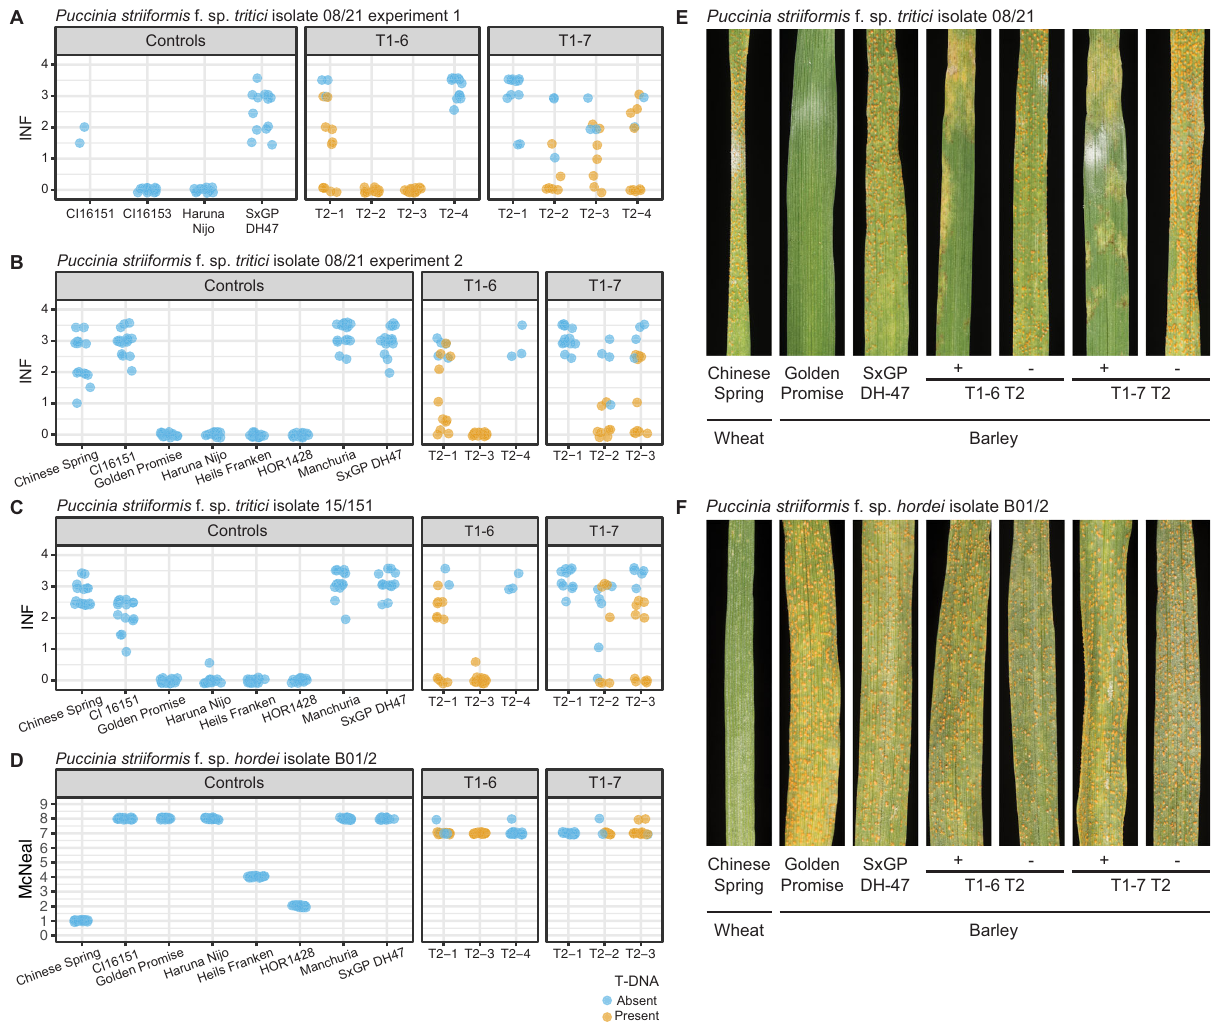
Fig. 6 Mla8 confers resistance to P. striiformis f. sp. tritici isolates 08/21 and 15/151, but not P. striiformis f. sp. hordei isolate B01/2. Advanced T 2 progeny from two independent single insert p6:Mla8:t6 transgenic families in the SxGP DH-47 genetic background were inoculated with P. striiformis f. sp. tritici isolates ( A , B ) 08/21 and ( C ) 15/151, and ( D ) P. striiformis f. sp. hordei isolate B01/2. Representative photos are shown for ( E ) P. striiformis f. sp. tritici isolate 08/21 and ( F ) P. striiformis f. sp. hordei isolate B01/2. Phenotypic scales used include infection (INF) for wheat stripe rust 47 (0.0 to 4.0 in 0.5 increments represent the degree of leaf area covered with pustules) and the McNeal scale for barley stripe rust 90 . Presence or absence of the p6:Mla8:t6 transgene is color coded orange or blue, respectively. Transparency and jittering were used to visualize multiple overlapping data points. Progeny from transgenic family T1-6 were selfed, generating hemizygous T-DNA families (T1-6 T2-2 and T1-6 T2-3), homozygous null (T1-6 T2-1). Progeny from transgenic family T1-7 were selfed, generating homozygous T-DNA (T1-7 T2-2), hemizygous T-DNA (T1-7 T2-1), homozygous null (T1-7 T2-3). Controls include the wheat accession Chinese Spring, and barley accessions CI16151 ( rps6 rps7( = Mla6) rps8 ), Golden Promise ( Rps6 Rps7 ( = Mla8 ) Rps8 ), Haruna Nijo ( Rps6 Rps7( = Mla8) Rps8 ), Heils Franken ( rps6 Rps7 ( = Mla37 ) rps8 ), and HOR1428 ( rps6 Rps7 rps8 ), Manchuria ( rps6 rps7 rps8 ) and SxGP DH-47 ( rps6 rps7 rps8 ). Heils Franken and HOR 1428 are resistant controls to P. striiformis f. sp. hordei isolate B01/2. Source data are provided as a Source Data fi